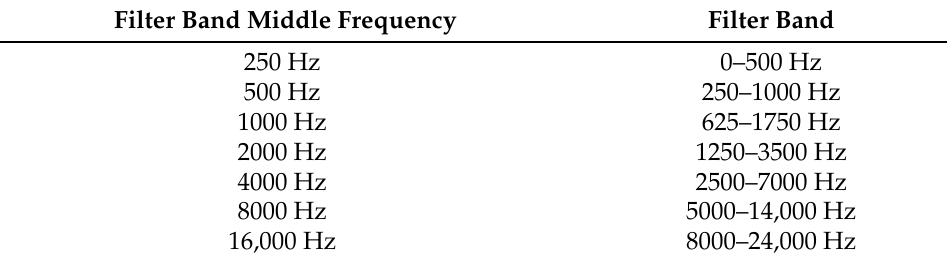
Figure 6. This figure presents the frequency bands energy estimation controller. Table 1. This table presents the frequency bands of